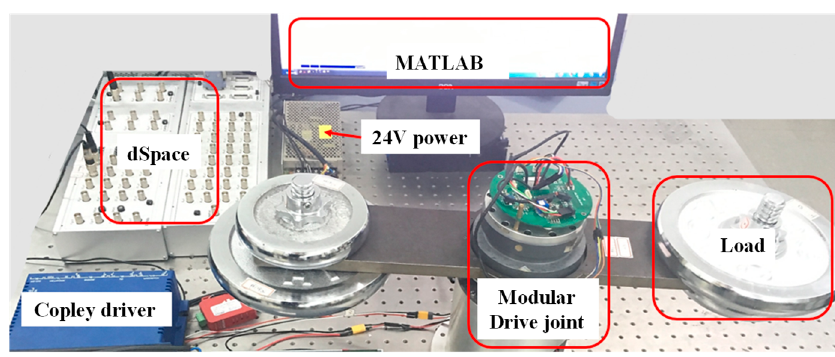
Figure 1. Physical diagram of experimental platform.